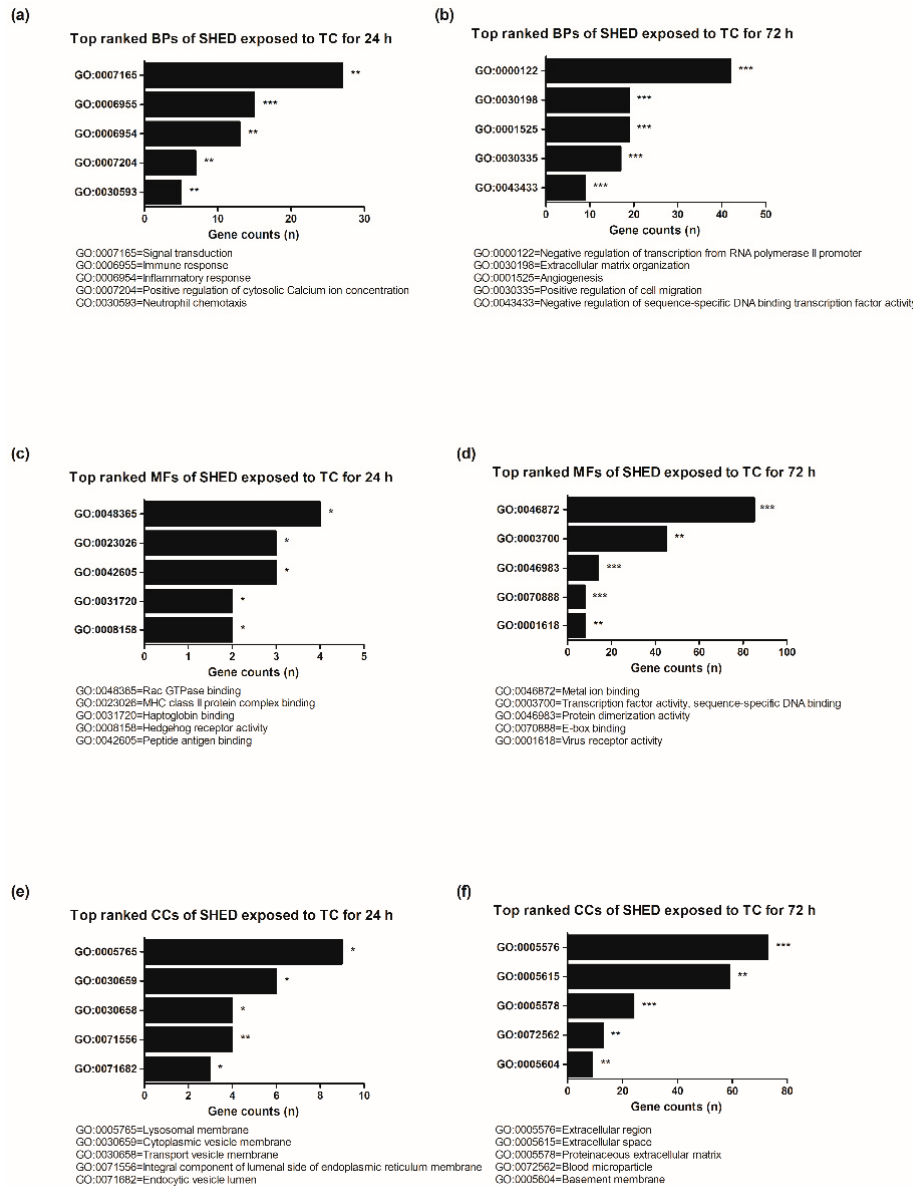
Figure 4. Database for Annotation, Visualization and Integrated Discovery (DAVID) functional gene ontology analysis of protein enrichment in TC compared to MTA. ( a , b ) Biological process of the cells exposed to TC. ( c , d ) Molecular function of the cells exposed to TC. ( e , f ) Cellular components exposed to TC. BP = biological process, MF = molecular function, CC = cellular component, * p < 0.05, ** p < 0.01, *** p < 0.001.